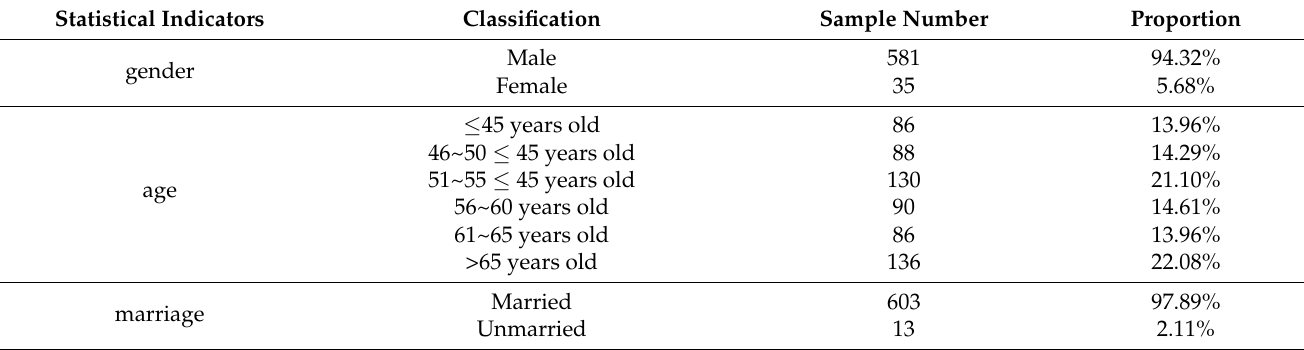
Table 2. Basic characteristics of